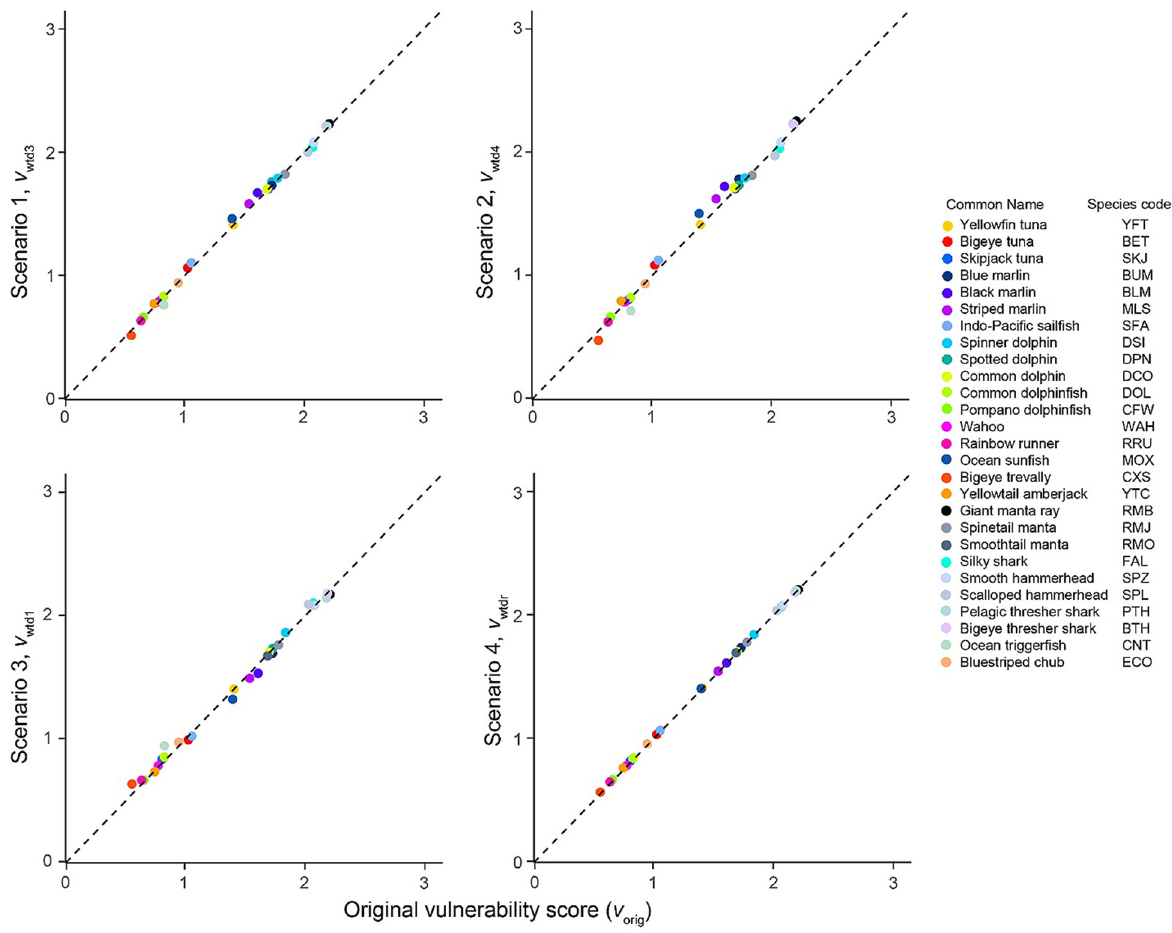
Fig. 2. Comparison of vulnerability scores using the default attribute weight of 2 for all productivity and susceptibility attributes used in the calculation of overall vulnerability scores ( v orig ) and those derived from various scenarios of weighting productivity attributes. Scenarios 1 and 2 involved maximum size ( L max ), intrinsic rate of population growth ( r ), and the von Bertalanffy growth rate coef fi cient ( K ) being upweighted to 3 ( v wtd3 ) and 4 ( v wtd4 ), respectively. Scenario 3 down-weighted these attributes to 1 ( v wtd1 ). Scenario 4 randomly weighted each productivity attribute from 1 to 4 ( v wtdr ). (For interpretation of the references to colour in this fi gure legend, the reader is referred to the web version of this